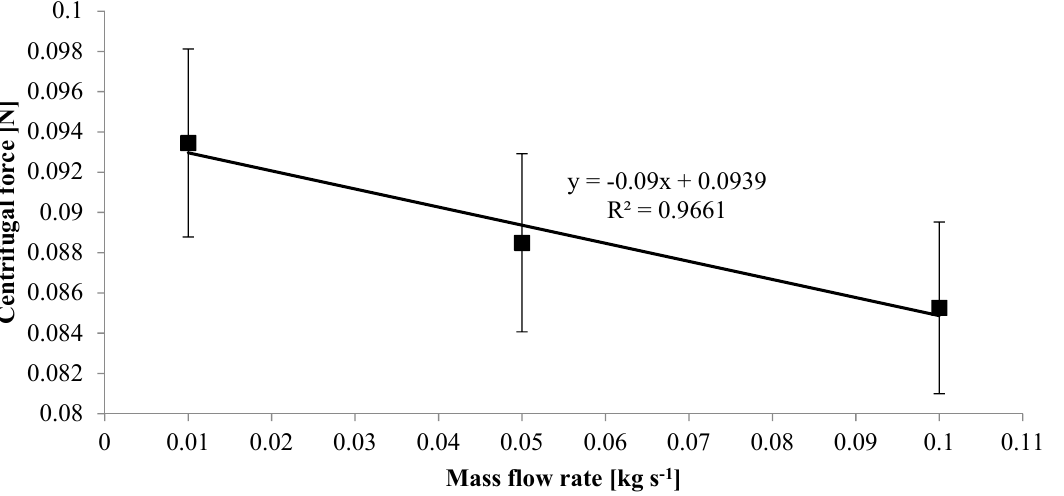
Figure 9. Centrifugal force acting on a particle in various mass flow rates with error bars of 10%.